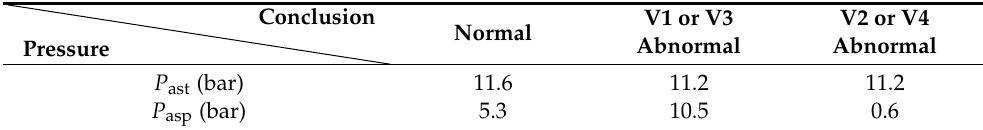
Table 4. Pressure data sheet for abnormal state test of solenoid